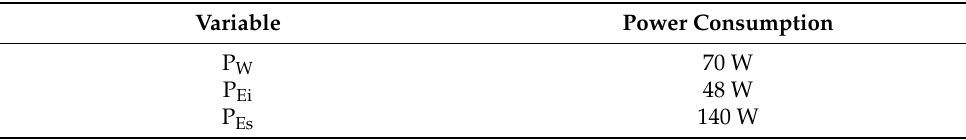
Table 3. Power consumption of WTMD and ETD